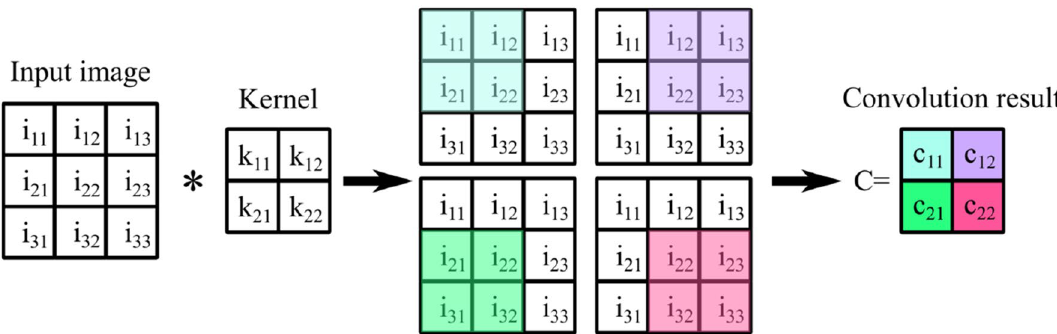
Figure 4. Illustration of convolving a 3 × 3 input image with a 2 × 2 kernel.